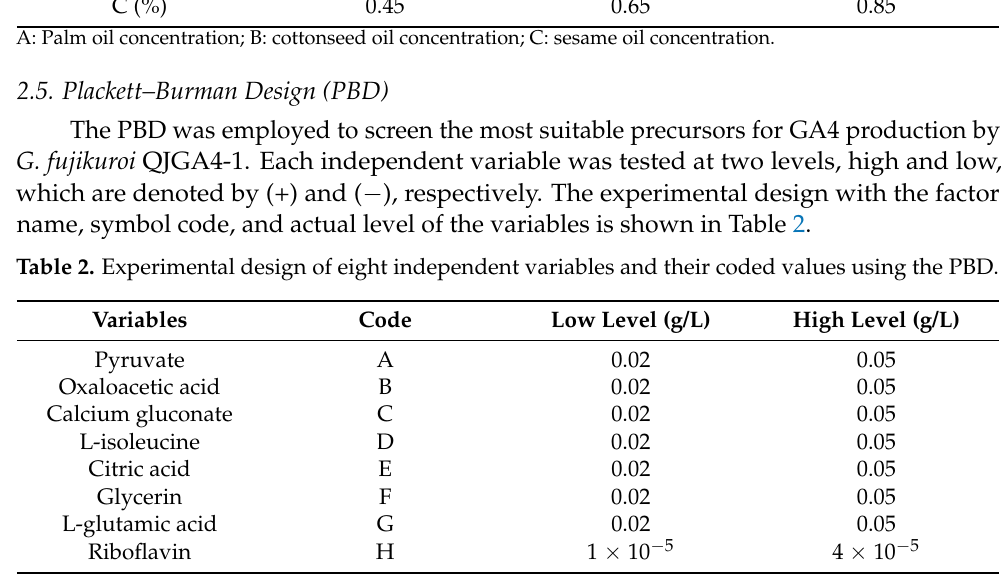
Table 1. Experimental design of three independent variables with their coded and actual values using BBD. Variables